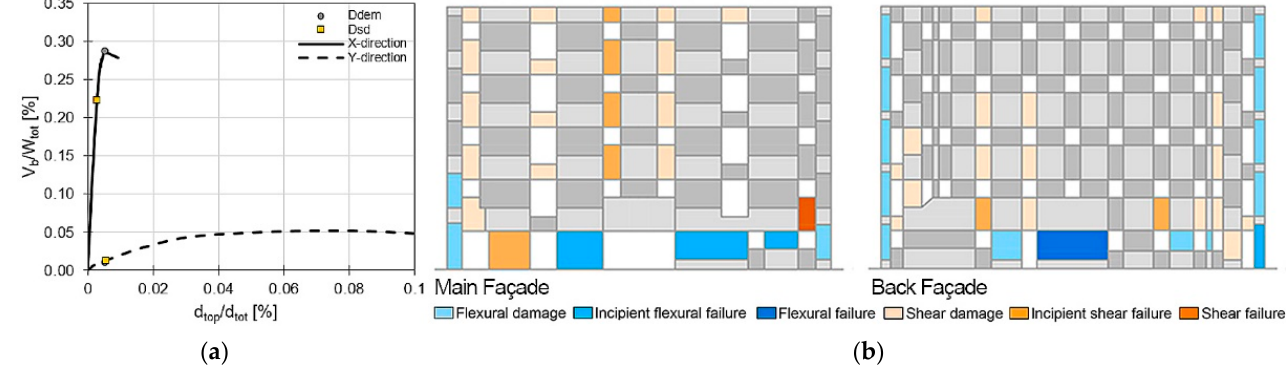
Figure 6. ( a ) Normalised SDOF-NLS curves plotting both the seismic demand ( d dem ) and the SD LS ( d SD ) for the as-built structure. ( b ) Damage at each single wall for the main and the back façade for the seismic demand step and the as-built condition.